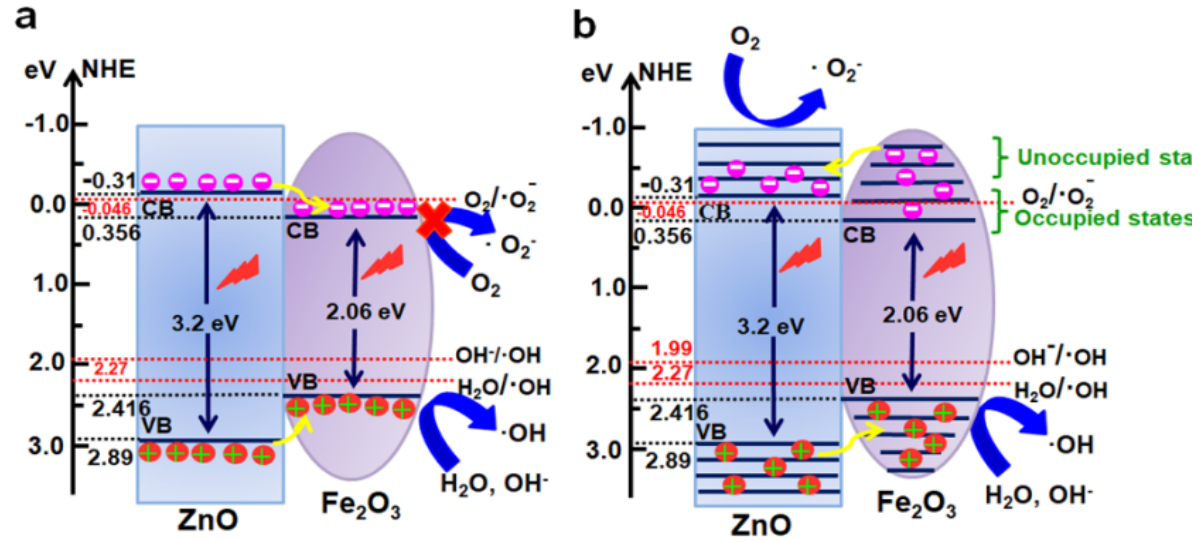
Figure 9. Schematic illustration for band-gap structure and transport of charge carriers of the ZnO/Fe 2 O 3 NFs during the UV light irradiation: ( a ) isotropic double charge transfer mechanism and ( b ) reverse double charge transfer mechanism.